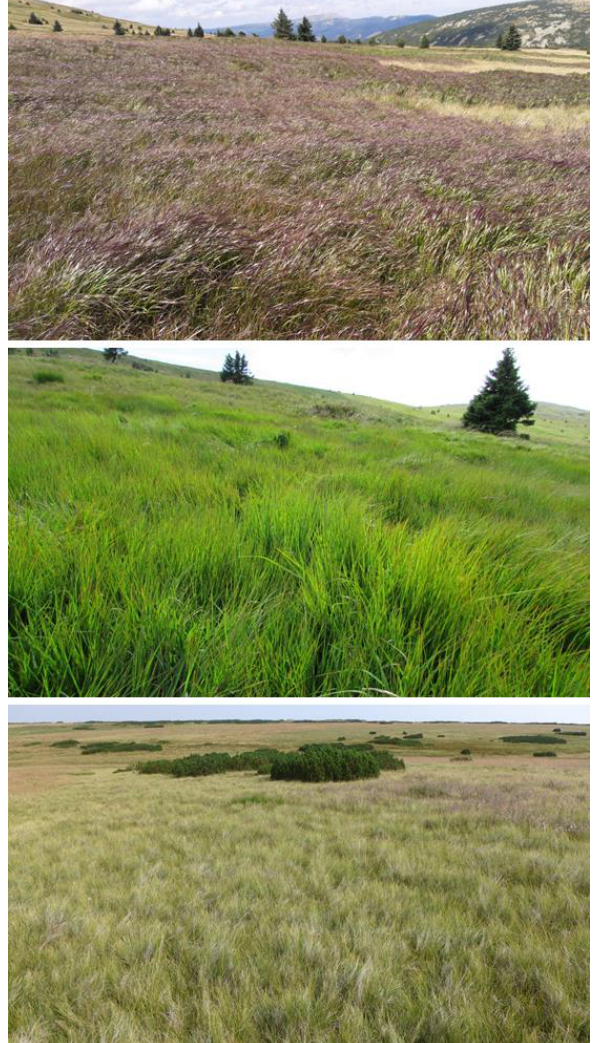
Figure 1. Calamagrostis villosa (up), Molinia caerulea (middle) and Nardus stricta (bottom) at the beginning of August The third type of spectral data was spectra extracted for 36 random points per species per date (36×3×3 = 324 pixels) from hyperspectral images acquired by Headwall Nano-Hyperspec® fastened to the DJI Matrice 600 Pro drone (Figure 2). The flight high was 68.9 m above the terrain to ensure ground sampling distance of the data 3 cm. The flights in June and August were carried out in sunny weather, so the exposure time were 4 or 5 ms, frame period 6 ms and the flight speed 5 m/s in both cases. The flight in July was carried out under a constant cloud cover, so the exposure time was 9 ms, frame period 10 ms and the flight speed 3 m/s. The scanned area had an extent of 100 m x 100 m. To achieve 40% sidelap, 10 flight lines were needed to cover the entire area. The radiometric corrections were performed using the portable 3 m x 3 m fabric target placed in the scanned area (Group 8 Technology, Inc., Provo, UT, USA) in the Headwall SpectralView - Hyperspec v3.1.0 software. The data cube consists of 270 bands, with wavelength ranging from 400 to 1,000